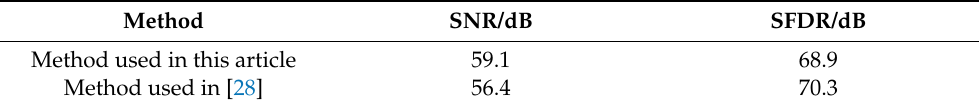
Table 1. Comparison of the correction effects of the methods in [28] and in this article.